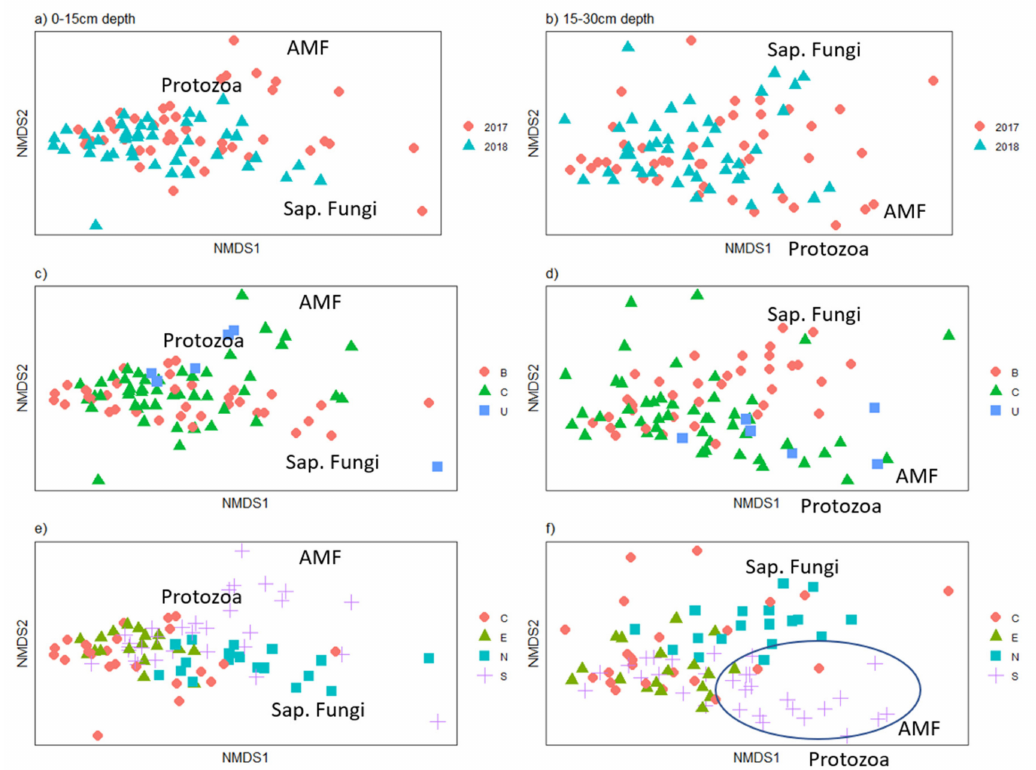
Figure 4. Soil microbial community composition in grasslands in 2017 and 2018. Shown for the 0–15 cm soil layer (left- a , c and e ), and the 15–30 cm layer (right- b , d and f ). Plotted by: Year: 2017 vs 2018 (Top row, a and b ). Permit area: B : 1972–1977 C : 1977–1982 U: Unmined (Second row, c and d ). Geographic location within site: C: Central E: East N: North S: south (bottom row, e and f ). Sap. Fungi- Saprophytic fungi. AMF- arbuscular mycorrhizal